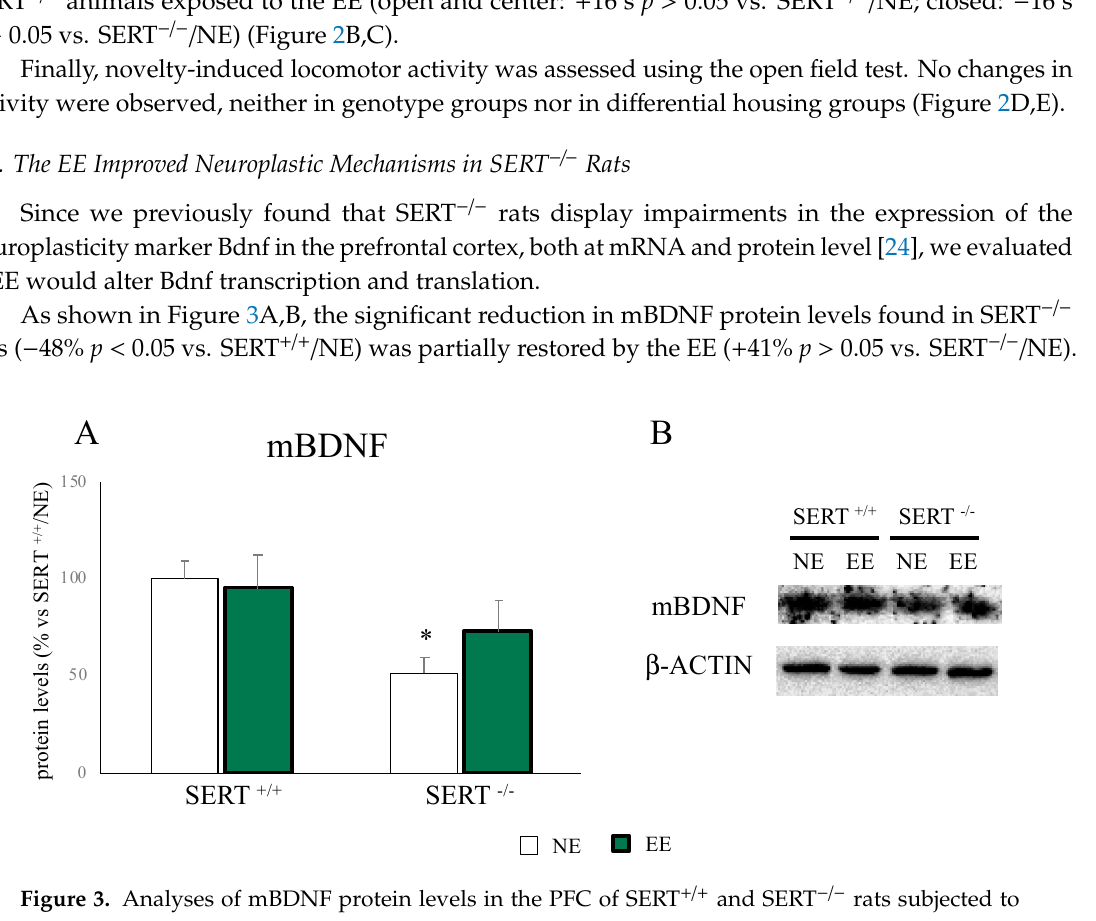
Figure 4. Analyses of PSD95 ( A ) and CDC42 ( B ) protein levels in PFC of SERT +/+ and SERT − / − rats subjected to one month of exposure to NE (normal environment) or EE (environmental enrichment)